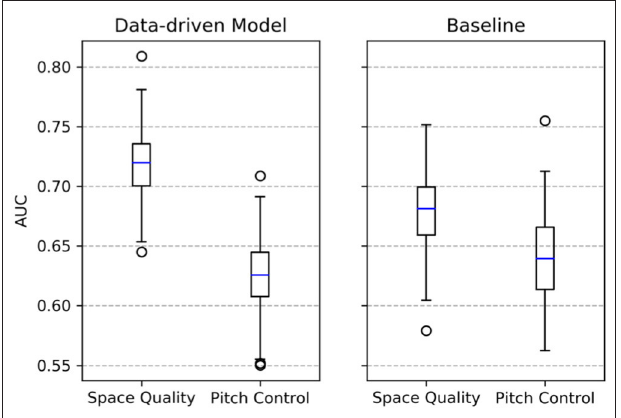
FIGURE 9 | The resulting area under the curve (AUC)